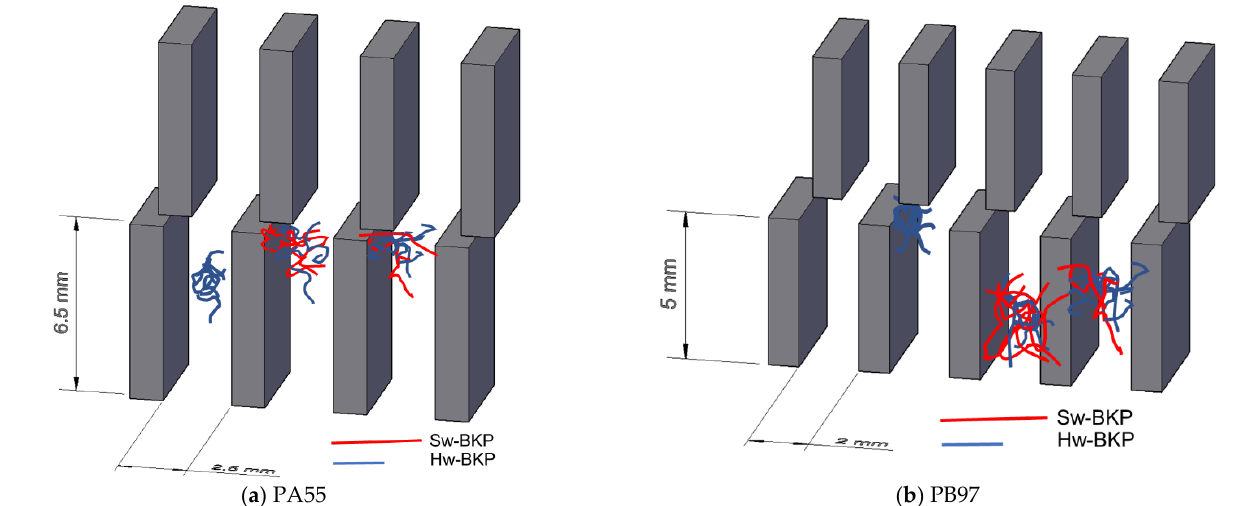
Figure 7. Effect of CEL on fiber flow during refining: ( a ) small flocs quickly pass through the groove but larger flocs are caught on the bar edges; ( b ) while small flocs are readily caught on the bar edge between the narrow grooves, larger flocs take more time to pass through the grooves.